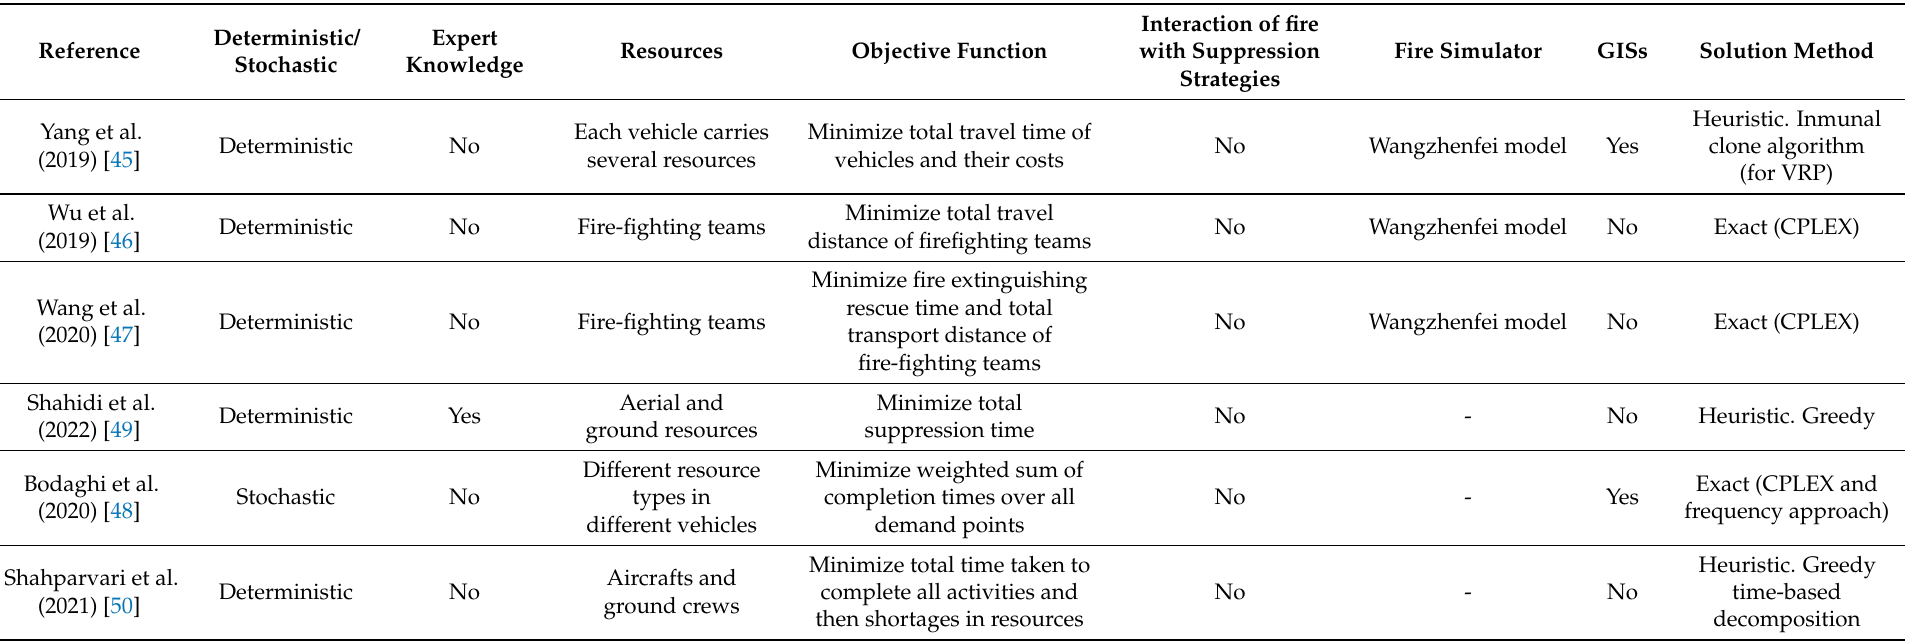
Table A3. List of main characteristics of papers that address the dispatch of resources for response. Fire-points